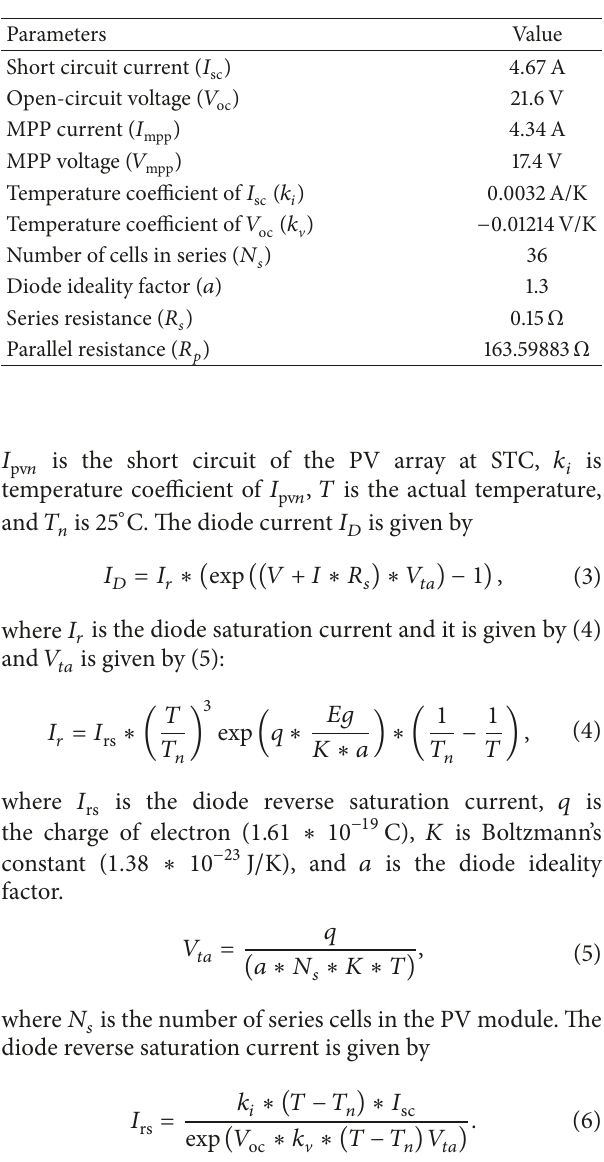
Table 3: Parameters of the ISOFOTON I-75 module at 25 ∘ C and 1000 W / m 2 .